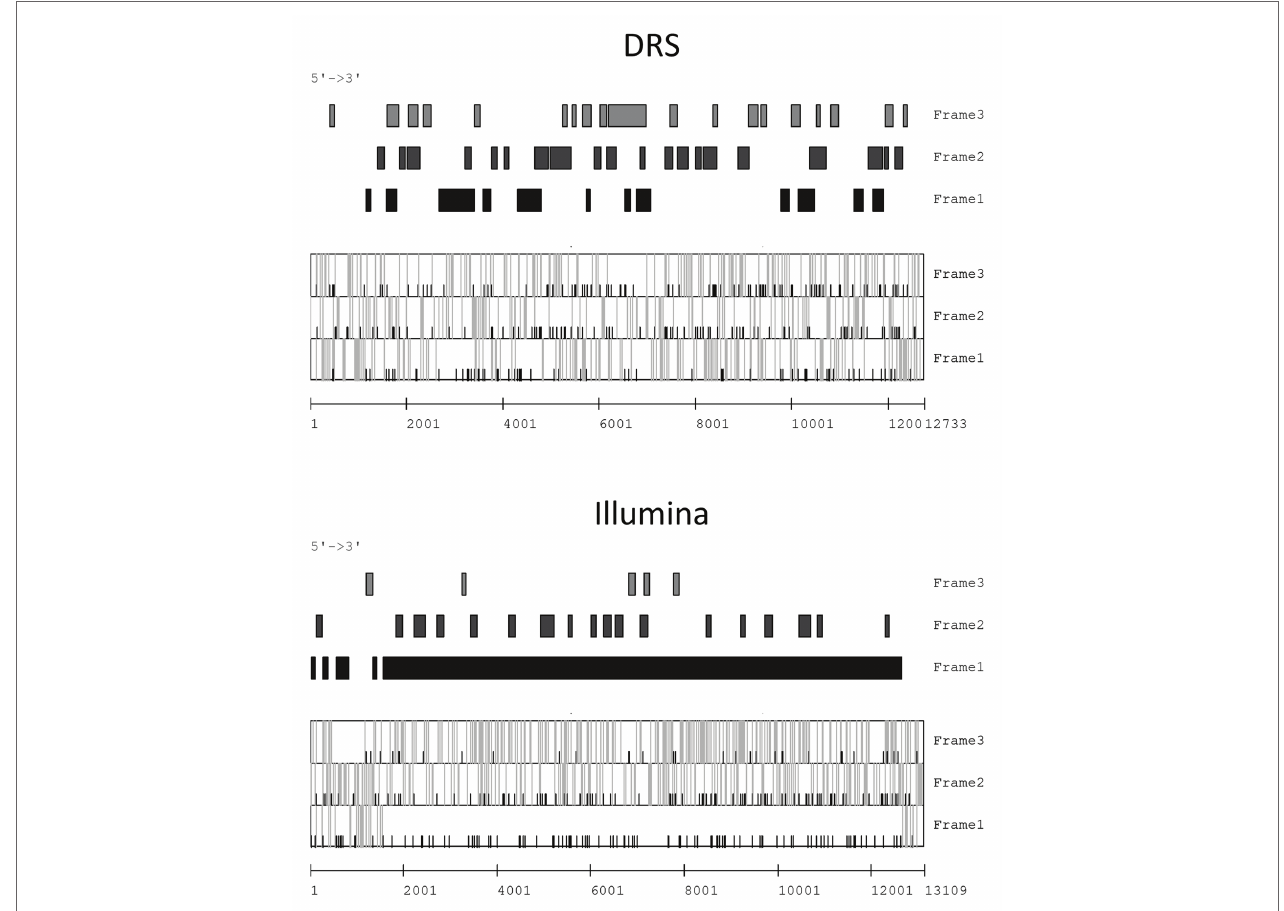
FIGURE 3 | Open reading frame (ORF) prediction of FsamHV1 contigs derived from DRS and Illumina reads. Prediction of the coding regions larger than 100 bp on the sense strand of FsamHV1 generated from DRS and Illumina reads (upper panels) . Prediction of the initiation codon (AUG) and the termination codons (UAA, UAG, and UGA) positions on each reading frame (lower panels) . Black bars indicate positions of initiation codons, and gray bars indicate those of termination codons in the lower